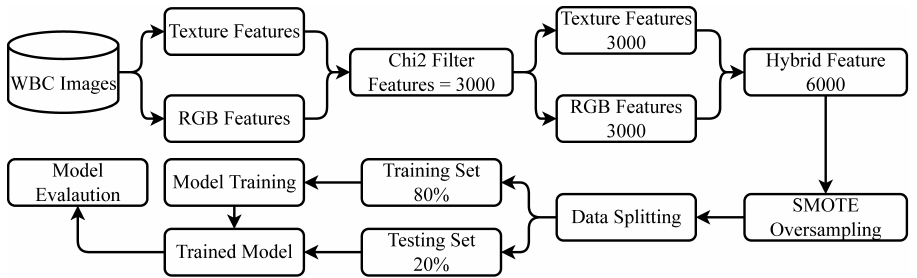
Figure 3. Flow of the proposed